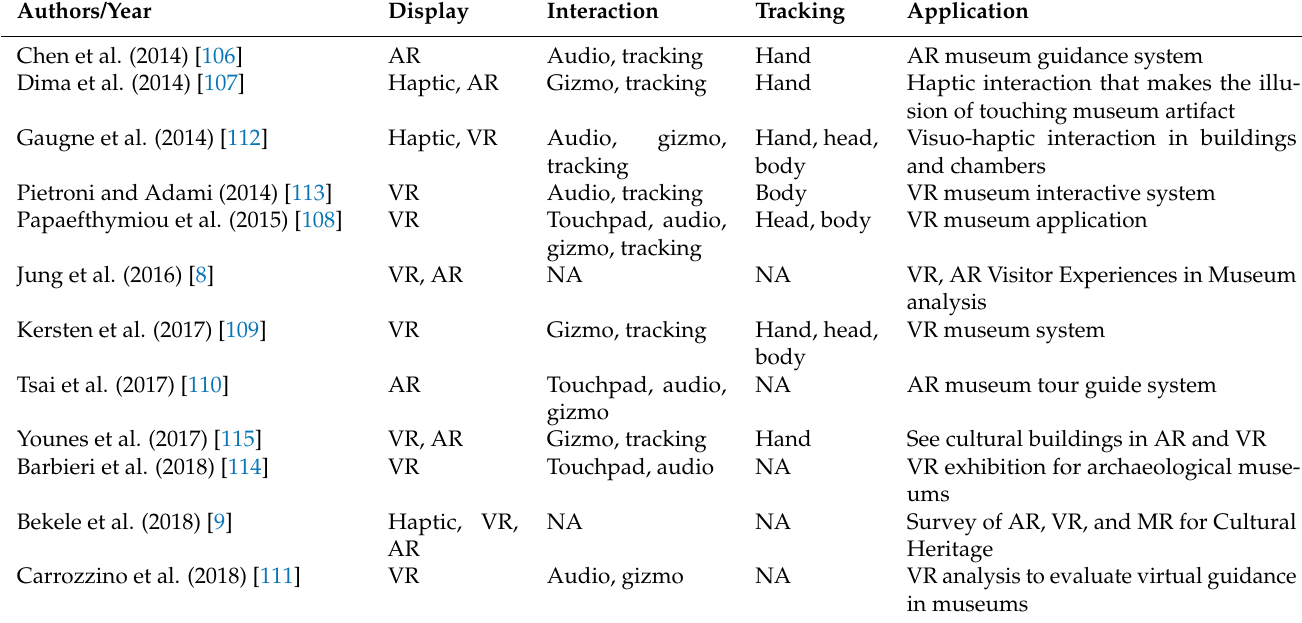
Table 7. Data table of the cultural heritage